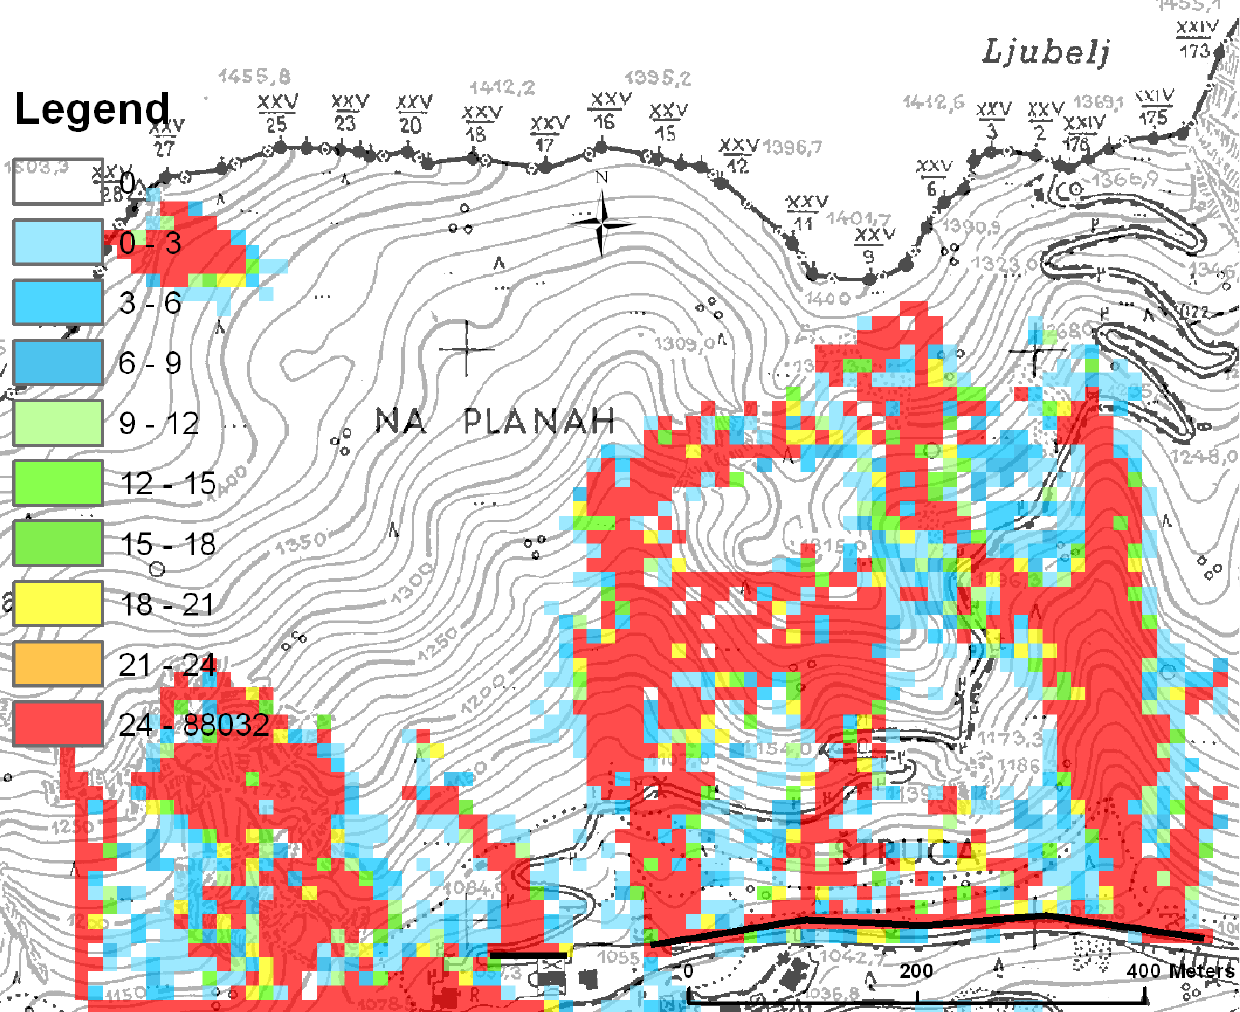
Figure A3. Number of deposited rocks for current forest scenario with rockfall retaining nets (3 m high, resistance 500 kJ, shown as black line above the